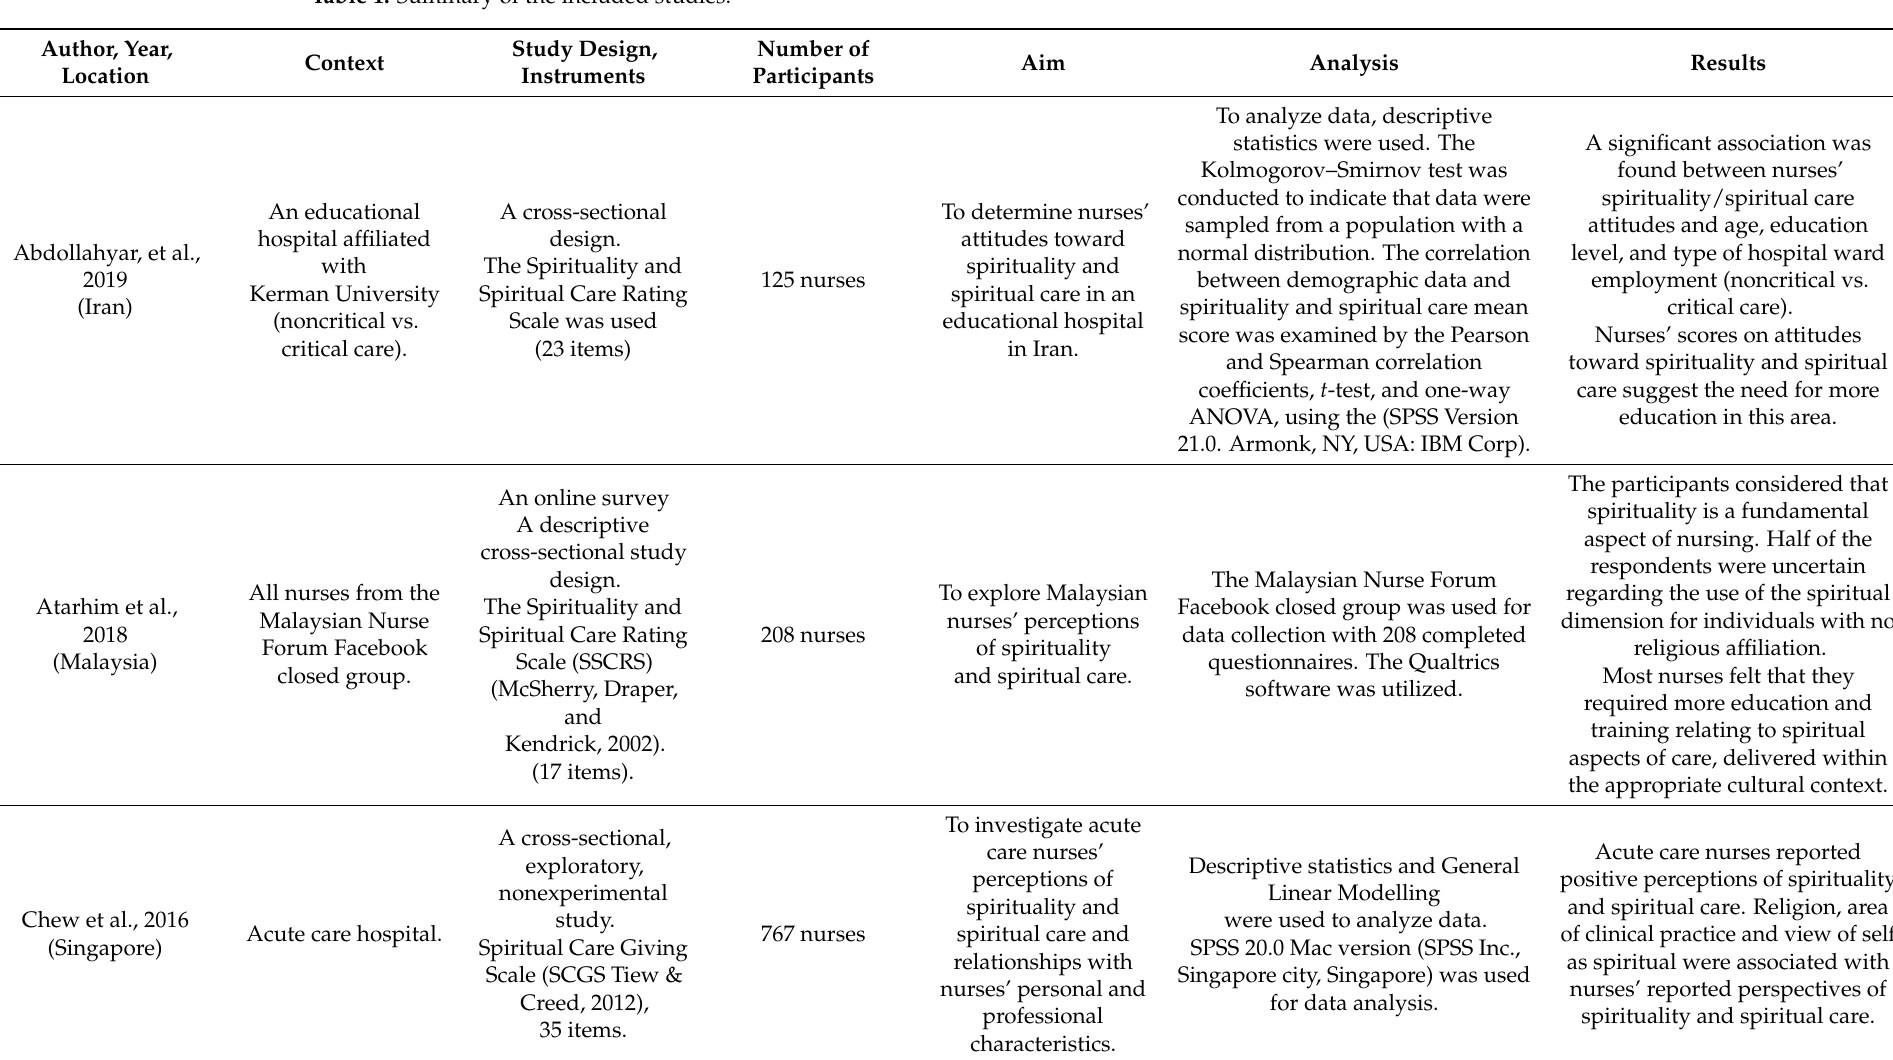
Table 1. Summary of the included